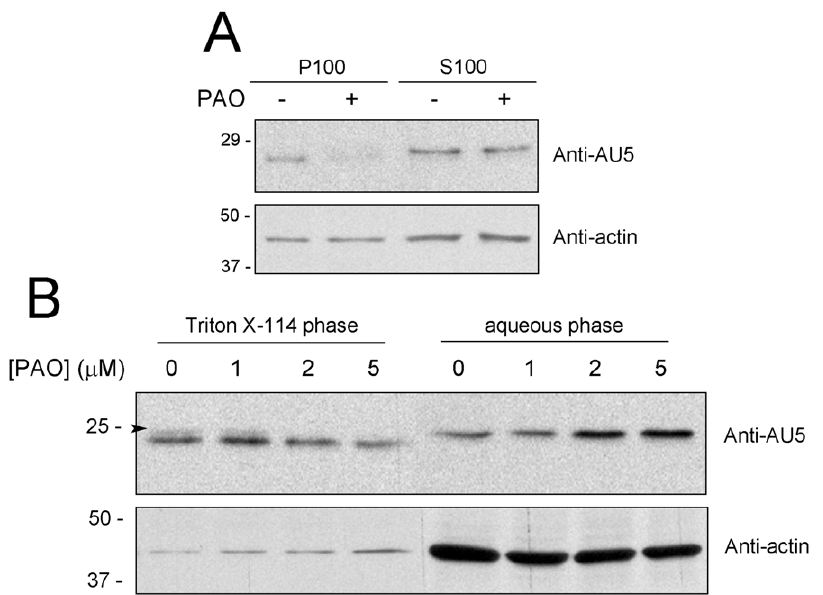
Figure 5. Effect of PAO on H-Ras subcellular localization. (A) COS-7 cells were transiently transfected with expression vectors coding for AU5- H-Ras wt. After serum starvation for 16 h, cells were treated with vehicle or 1 m M PAO for 1 h. Cells were lysed and postnuclear supernatants were separated into S100 and P100 fractions by ultracentrifugation at 200,000 6 g for 30 min. (B) AU5-H-Ras transfected cells were treated with the indicated concentrations of PAO for 90 min and cell lysates were subjected to fractionation in Triton-X114. The amount of AU5-H-Ras present in the various fractions was estimated by western blot with anti-AU5 antibody (upper panels). The upper component of the H-Ras doublet is indicated by an arrowhead. Levels of actin were assessed as control (lower panels). Blots shown are representative of three assays.